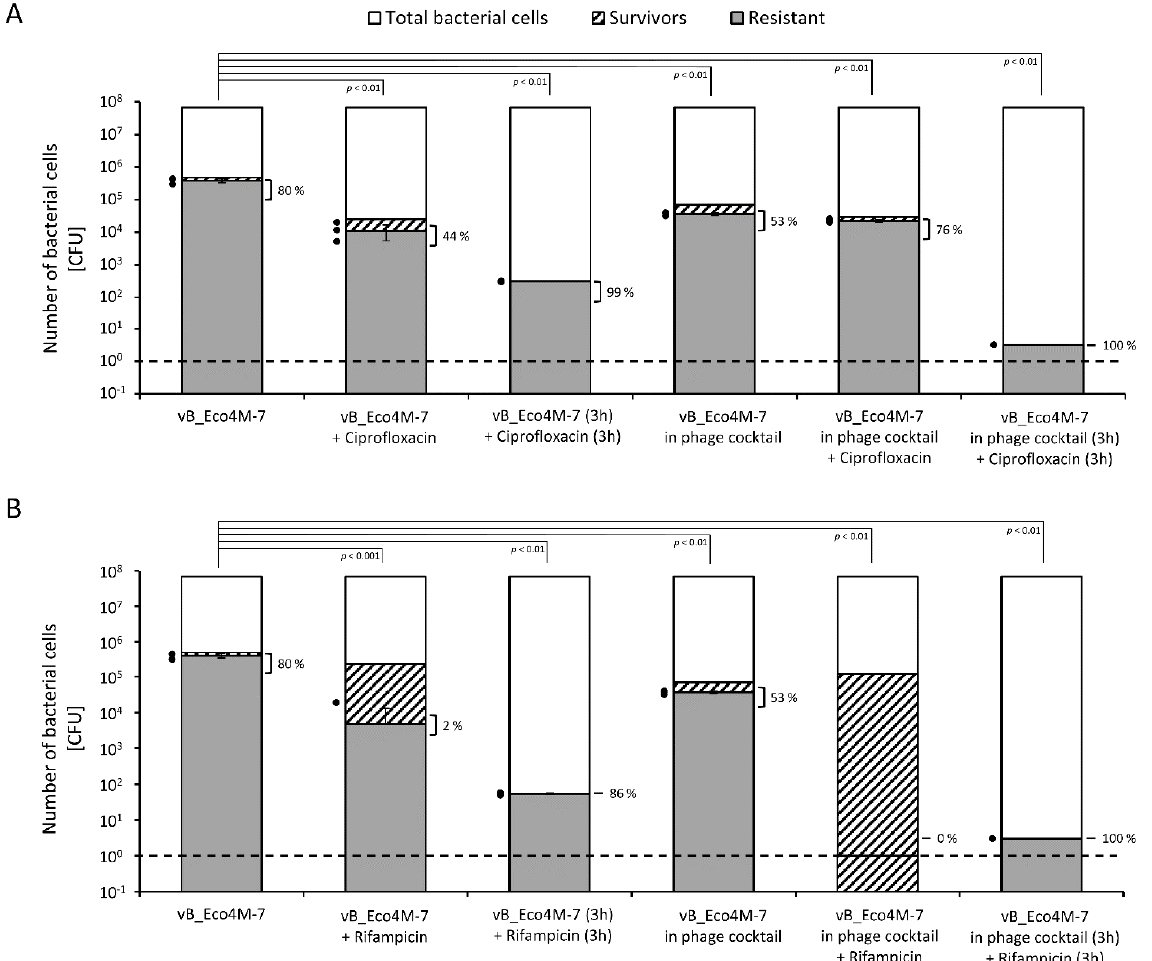
Figure 5. Number of surviving cells (columns with black stripes) and phage-resistant E. coli O157:H7 (ST2-862) mutants (gray columns) among survivors after biofilm treatment for 6 h with tested phage, individually or in combinations with ciprofloxacin ( A ) or rifampicin ( B ); vB_Eco4M-7 phage (MOI of 100), vB_Eco4M-7 phage (MOI of 100) mixed with antibiotic, vB_Eco4M-7 phage (MOI of 100) replaced after a 3-h incubation with antibiotic, the phage cocktail (MOI of 100), the phage cocktail (MOI of 100) mixed with antibiotic, the phage cocktail (MOI of 100) replaced after a 3-h incubation with the antibiotic. Control represents the total number of bacterial cells (white columns) after treatment with LB medium instead of tested antimicrobial agents. Additionally, the percentage of phage-resistant mutants (gray columns) among survivors (columns with black stripes) was calculated and presented next to the clamps. The black dashed lines represent the lower limit of detection. Mean values from three independent experiments are shown with error bars indicating SD. The black dots next to the columns denote datapoints for phage-resistant mutants from individual experiments. Statistical analyses were performed using the one-way ANOVA ( p value < 0.05 was considered statistically significant).